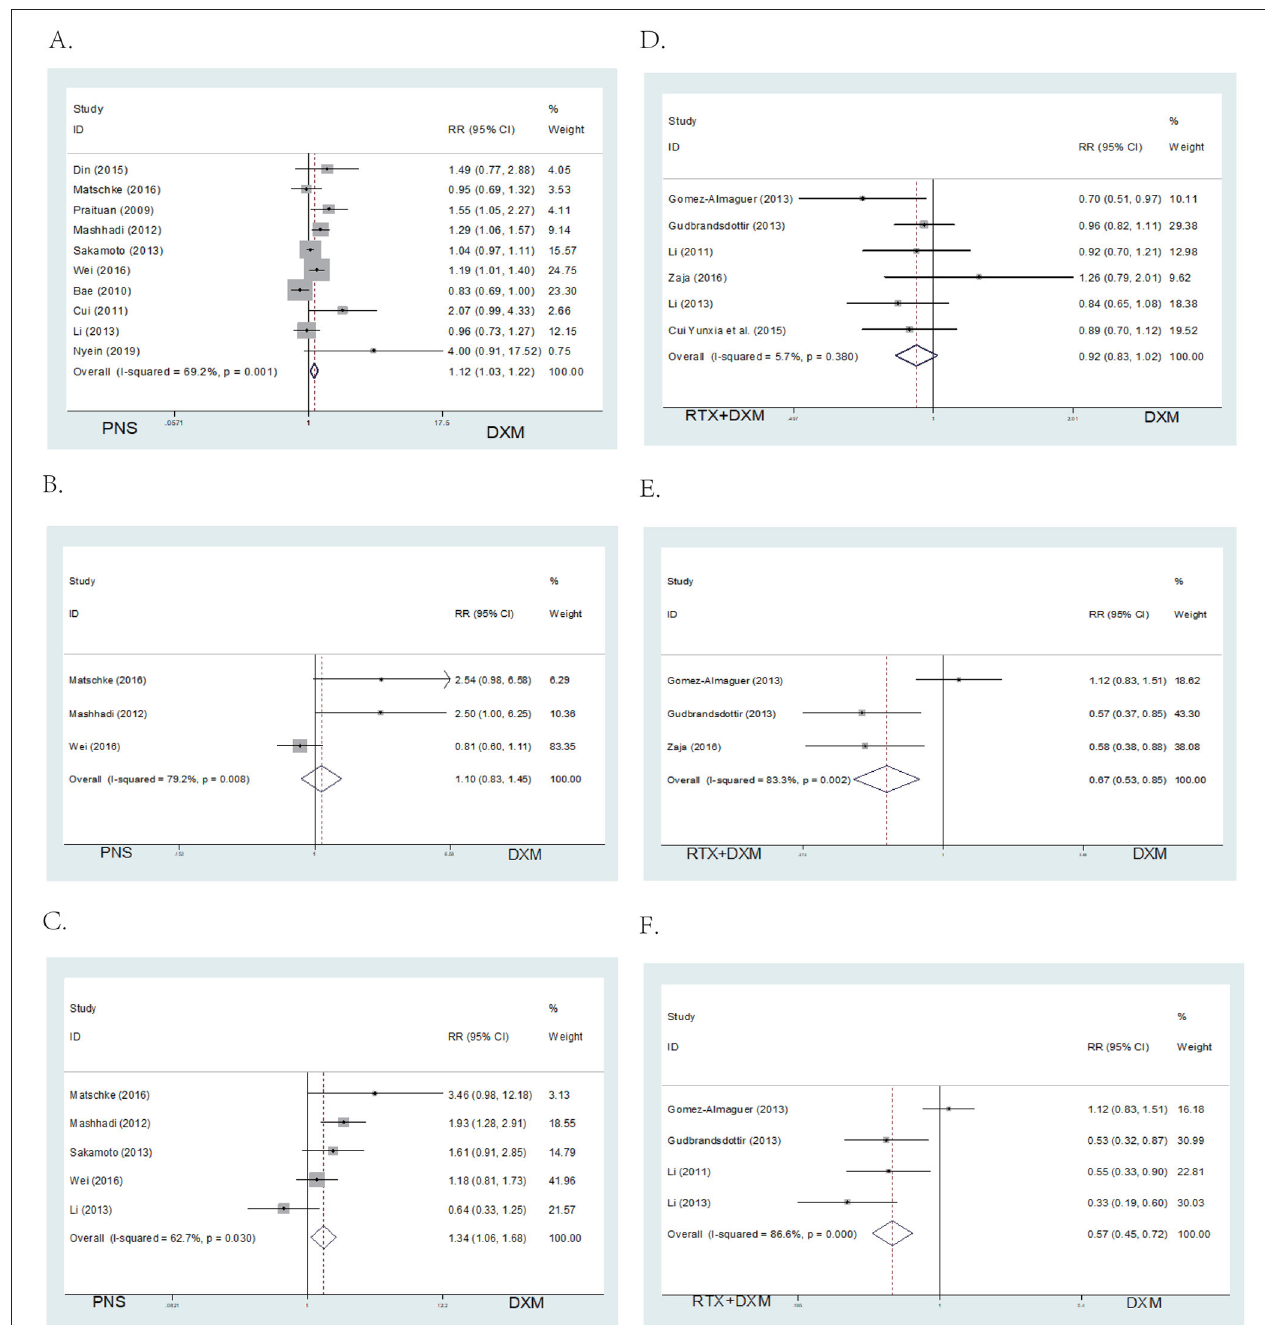
FIGURE 4 | Forest map of OR or SR. (A) DXM vs. PNS’s OR. (B) DXM vs. PNS’s SR (6 month). (C) DXM vs. PNS’s SR (12 month). (D) DXM vs. RTX + DXM’s OR. (E) DXM vs. RTX + DXM’s SR (6 month). (F) DXM vs. RTX + DXM’s SR (12 month).